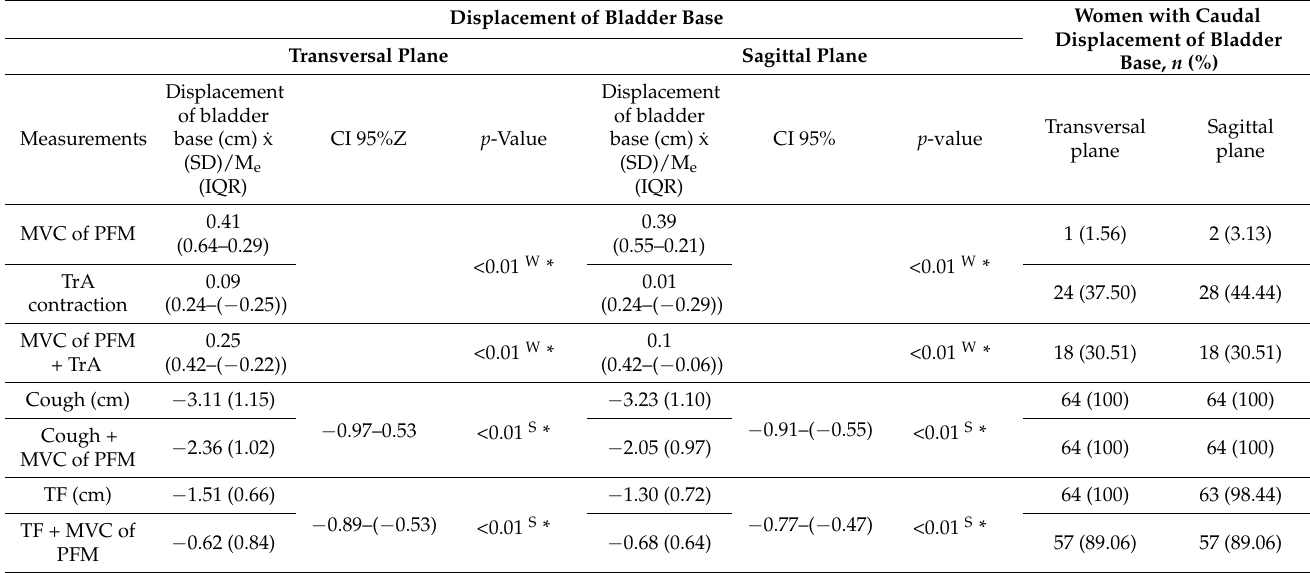
Table 4. Displacement of bladder base during physiotherapy assessment with functional ultrasound. Displacement of Bladder Base Women with Caudal